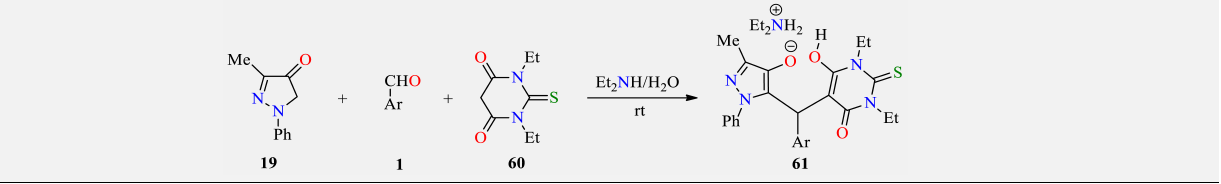
Table 17. Three-component synthesis of pyrazole-thiobarbituric derivatives 61 and their in vitro antibacterial activity against three Gram-positive bacterial strains.